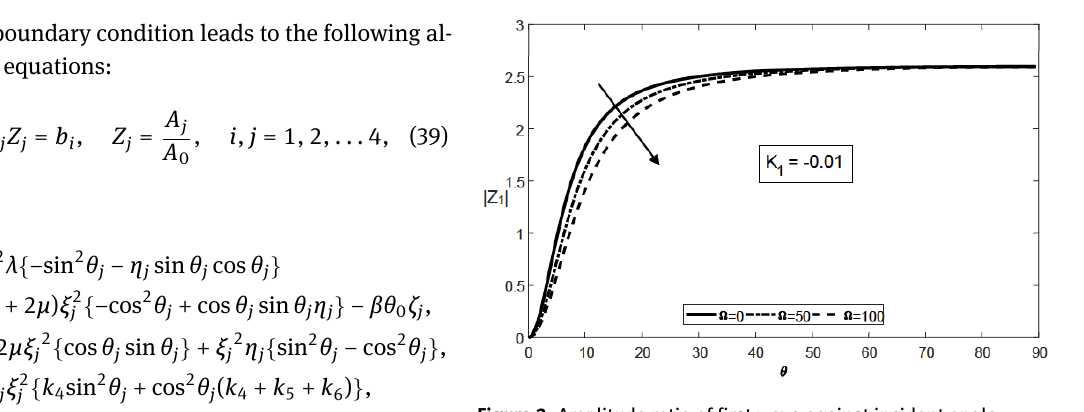
Figure 2: Amplitude ratio of first wave against incident angle